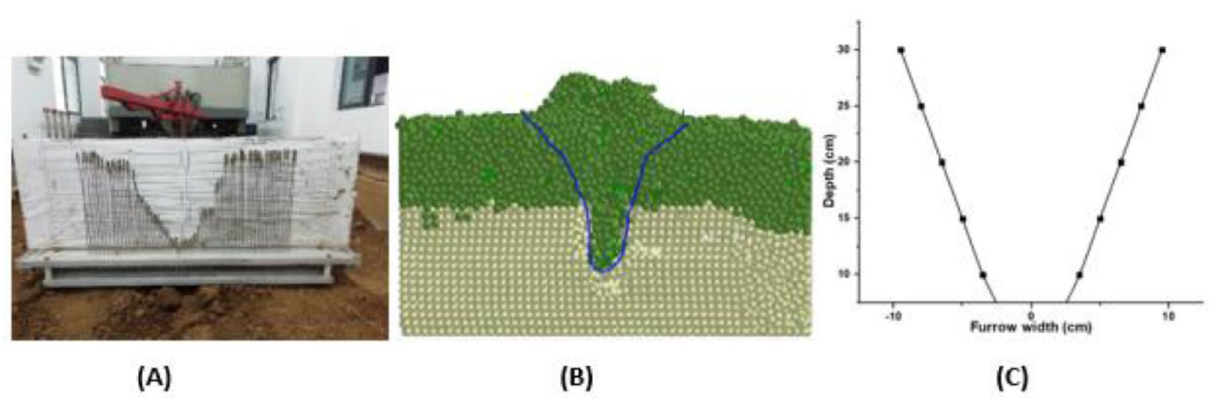
Figure 11. The furrow profile formed after passage of subsoiler during tillage operations ( A ) Soil bin experiment ( B ) DEM model created using EDEM 2018 software, DEM Solutions Ltd. (https:// www. edems imula tion. com/ softw are/) ( C ) Analytical